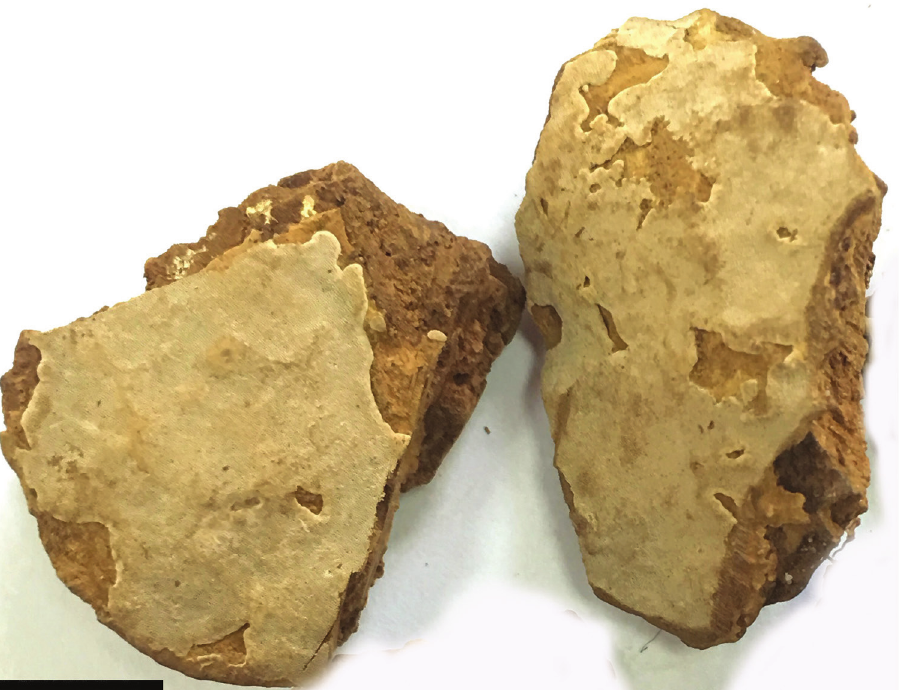
Figure 2. Basidiocarps of Perenniporia pseudotephropora (Holotype, Y.C. Dai 17383). Scale bar: 1 cm. Photo by Fang